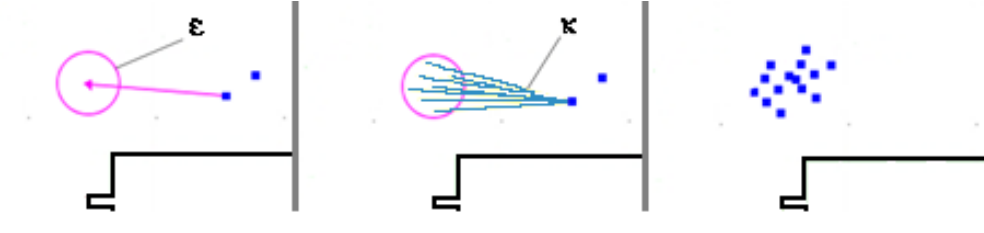
Figure 6. Step sensing error procedure. The system measures a motion vector and sets a plausible error (cid:15) around it ( left ). The system generates κ vectors within the error ( center ). Each of the generated vectors is applied to every particle, resulting in a new, larger cloud ( right ). Particles of the previous step are removed.